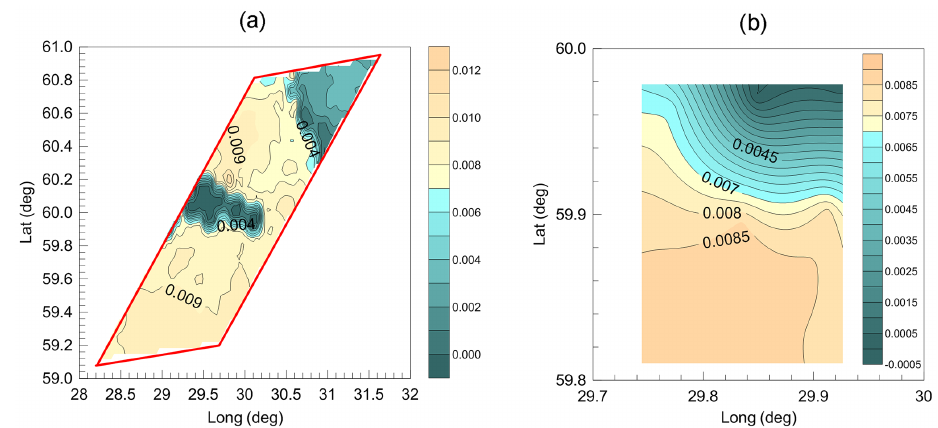
Figure A1. The maps of the median LWP values (kgm − 2 , colour scale) calculated for the large terrain (a) and small terrain (b) and for the 2-year period 1 December 2012–30 November 2014 (measurements by the SEVIRI instrument).